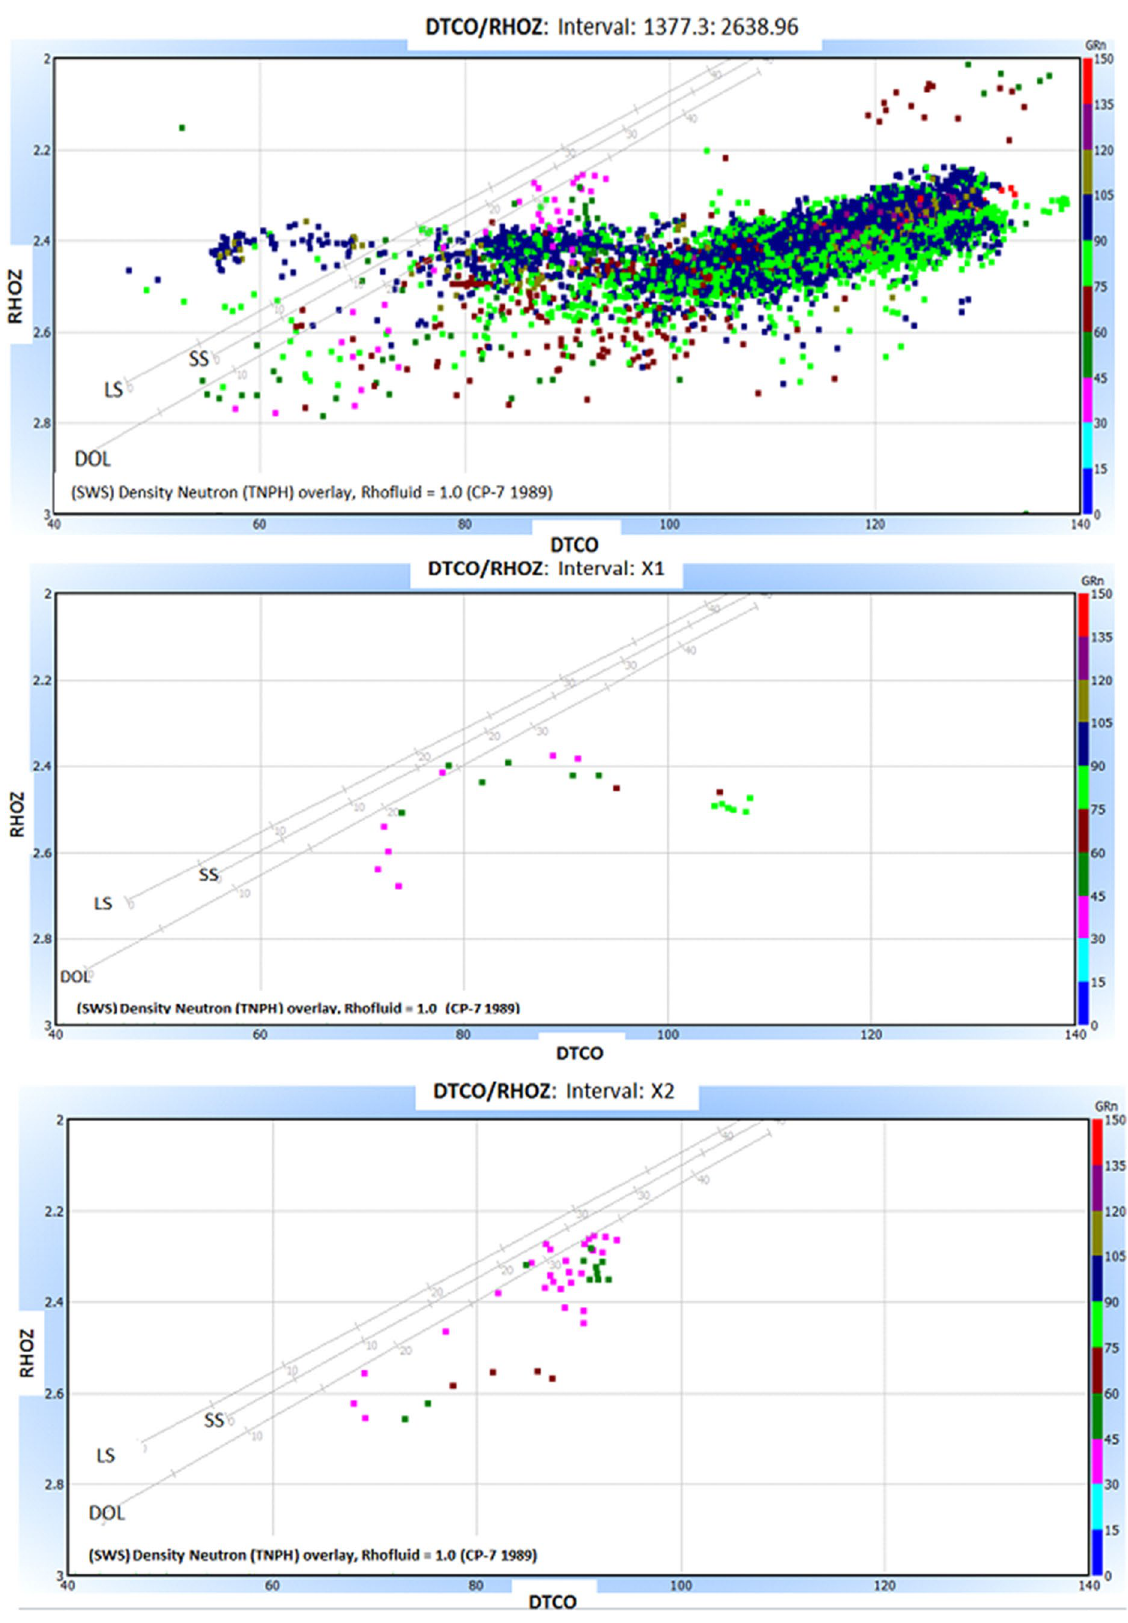
Fig. 6 Sonic–Density Crossplots for Well- X reservoir showing points scattered across the various fields indicating the heterogeneous nature of the